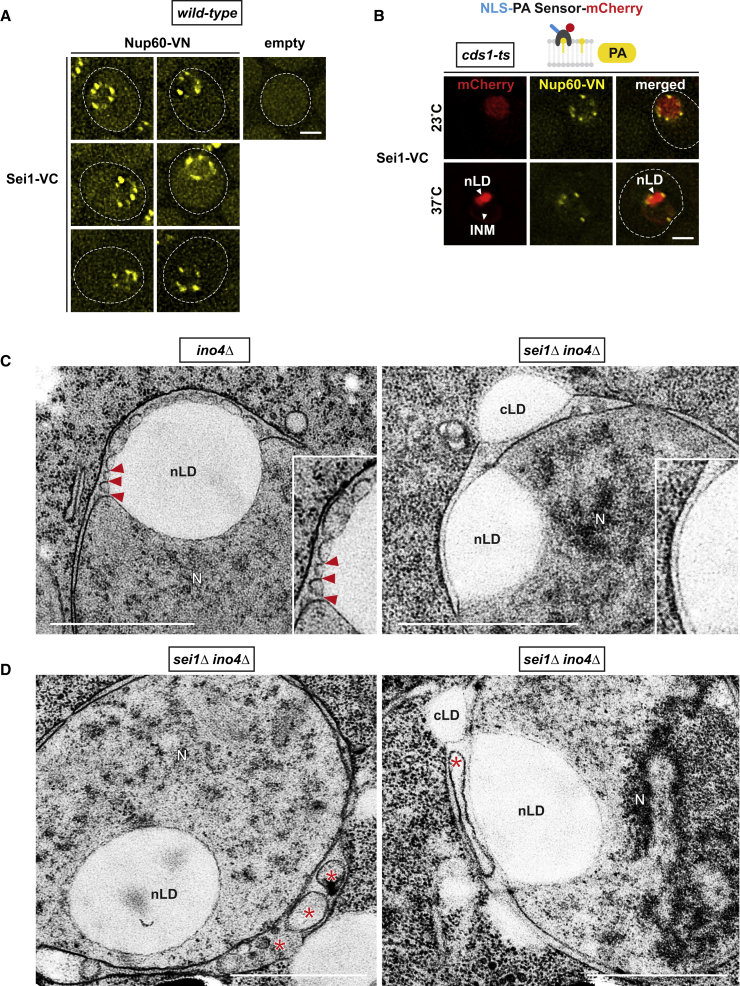
Seipin Regulates Formation of INM-nLD Membrane Bridges(A) Live imaging of representative cells expressing the indicated BiFC constructs. Empty vector co-expressed with Sei1-VC is used as a control. Scale bar, 2 μm.(B) Live imaging of cds1-ts cells expressing the NLS-PA-mCherry sensor and BiFC constructs. Cells were grown for 4 hr at the indicated temperatures. Scale bar, 2 μm.(C) Representative TEM images of ino4Δ cells and sei1Δ ino4Δ cells. An nLD is connected to the INM via numerous membrane bridges (red arrowheads) in the ino4Δ cell, which are absent in the sei1Δ ino4Δ mutant. Scale bar, 1 μm.(D) INM evaginations in the periplasmic space have highly irregular shapes and sizes (red asterisks) in sei1Δ ino4Δ cells (compare with Figure 4I). Scale bar, 1 μm.See also Figure S6.